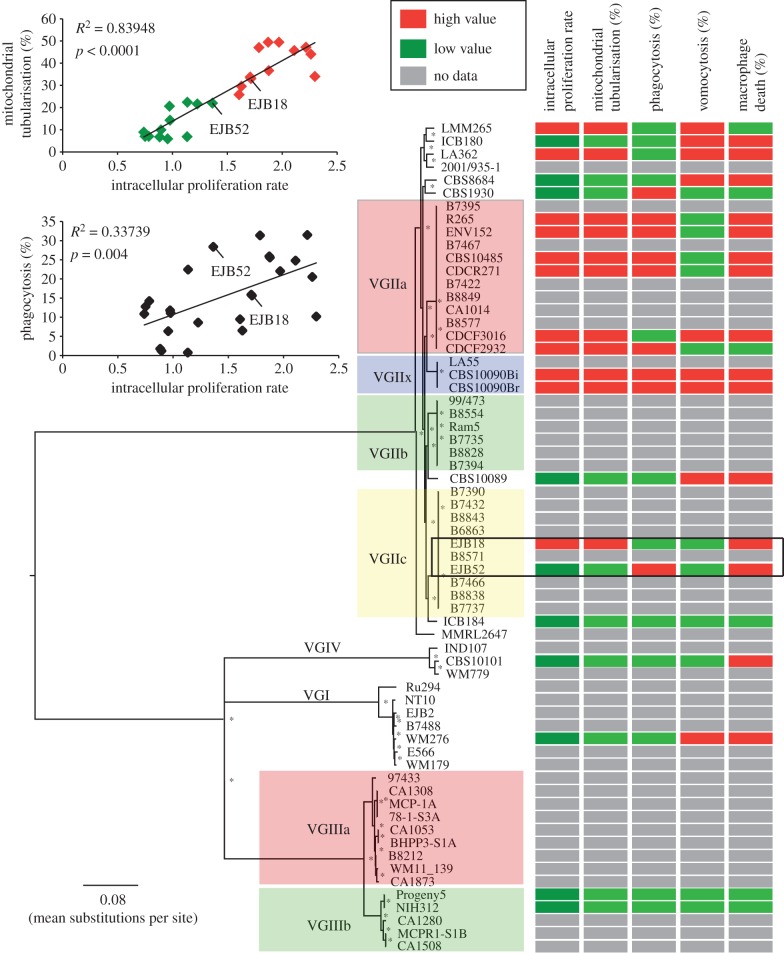
Correlation of phylogenetic and phenotypic data. Phenotypic data were superimposed onto the phylogenetic reconstruction of the nuclear genome and the data clustered into high- and low-value groups using a k-means clustering approach. The abilities to proliferate within macrophages and to form tubular mitochondria upon engulfment are strong virulence markers. (Top left) Mitochondrial tubularization and yeast uptake by macrophages were correlated (p < 0.0001 and p = 0.004, respectively) with their intracellular proliferative rate (IPR). Asterisks indicate 100% bootstrap support from 1000 replicates, and a box is used to highlight the VGIIc isolates that have shifts in phenotype.